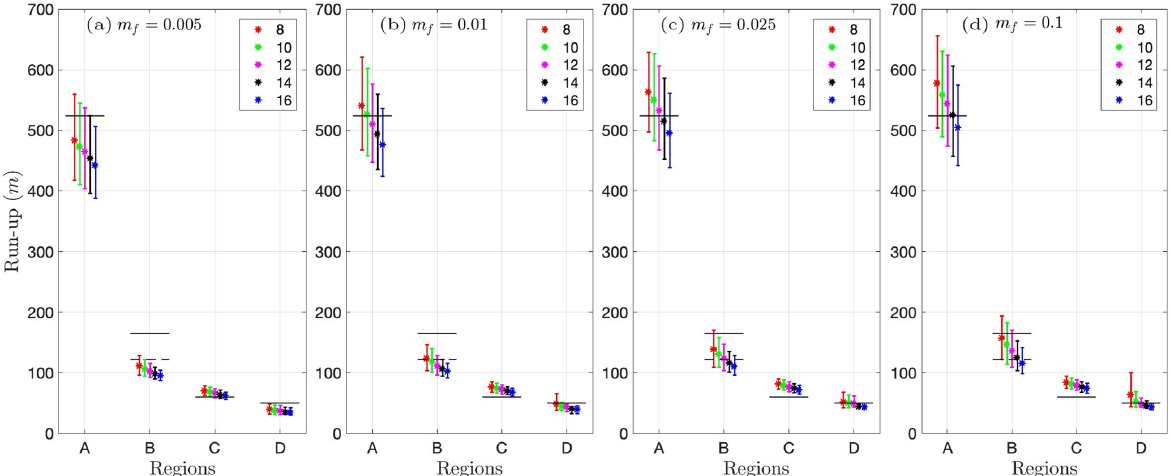
Figure 8. For a fixed value of the friction coefficient, m f (in (a) m f = 0 . 005; (b) m f = 0 . 01; (c) m f = 0 . 025; and (d) m f = 0 . 1), the maximum computed run-up in the four regions defined in Fig. 6 for different values of the Coulomb friction angle, α (in different colors; see legend), is presented. The vertical bars show the run-up variation for values of r ranging from 0 . 3 to 0 . 6.